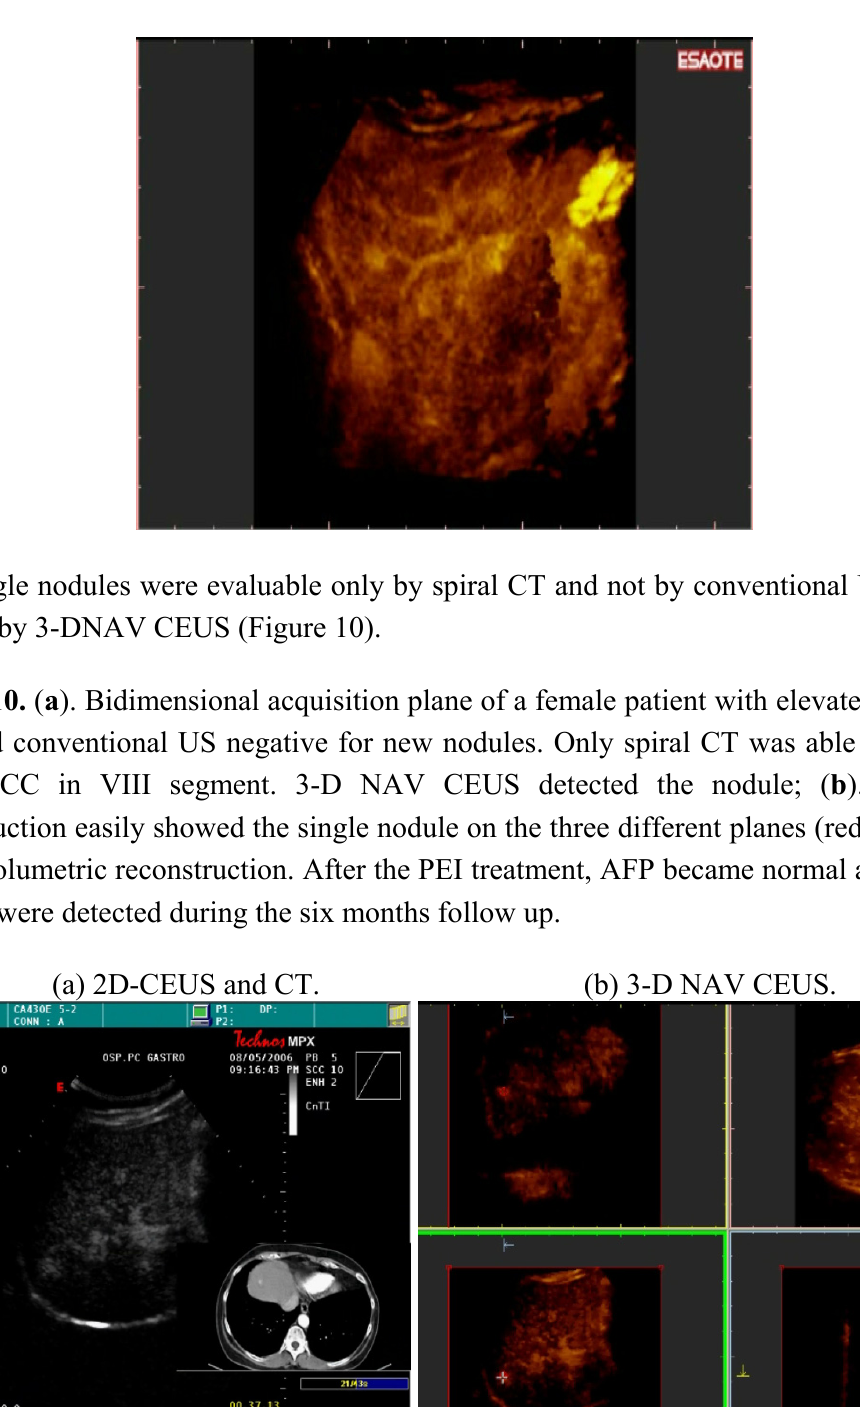
Figure 9. New multinodular HCC of the IV segment. These nodules were not visible with conventional US. 3-D NAV CEUS was performed due to the appearance of elevated values of